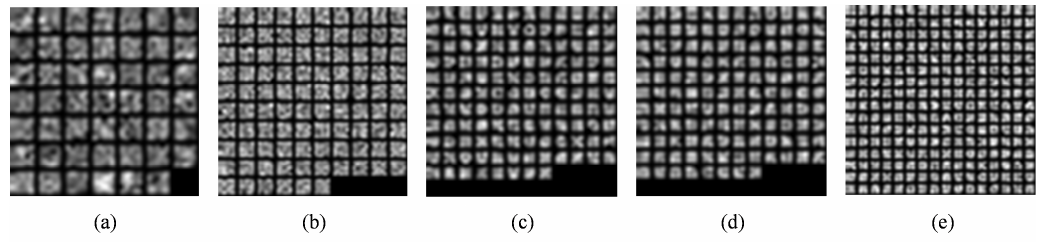
Figure 6. Training results of reconstruction pathway (baseline). ( a – e ) the kernels of convolutional layers 1 – 5, respectively.